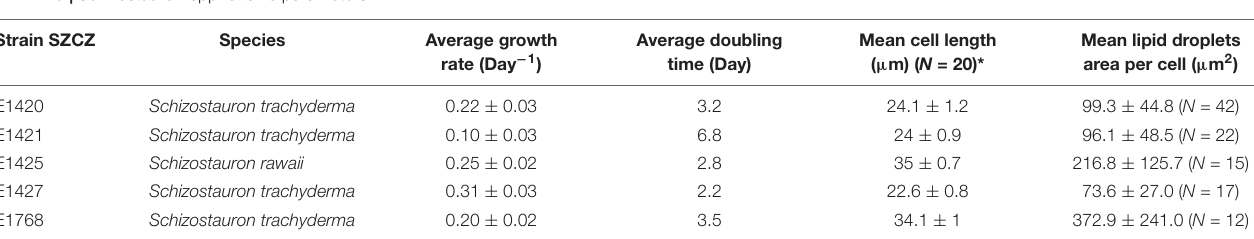
TABLE 3 | Schizostauron spp. strains